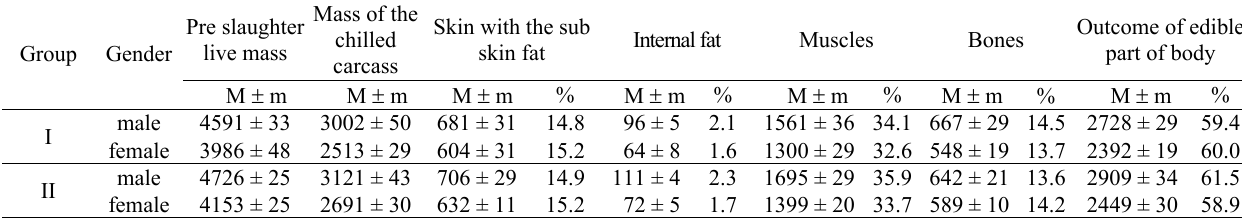
Morphological content of geese carcasses of the researched groups, gr. and % to the mass of the carcass (М  m) n = 3